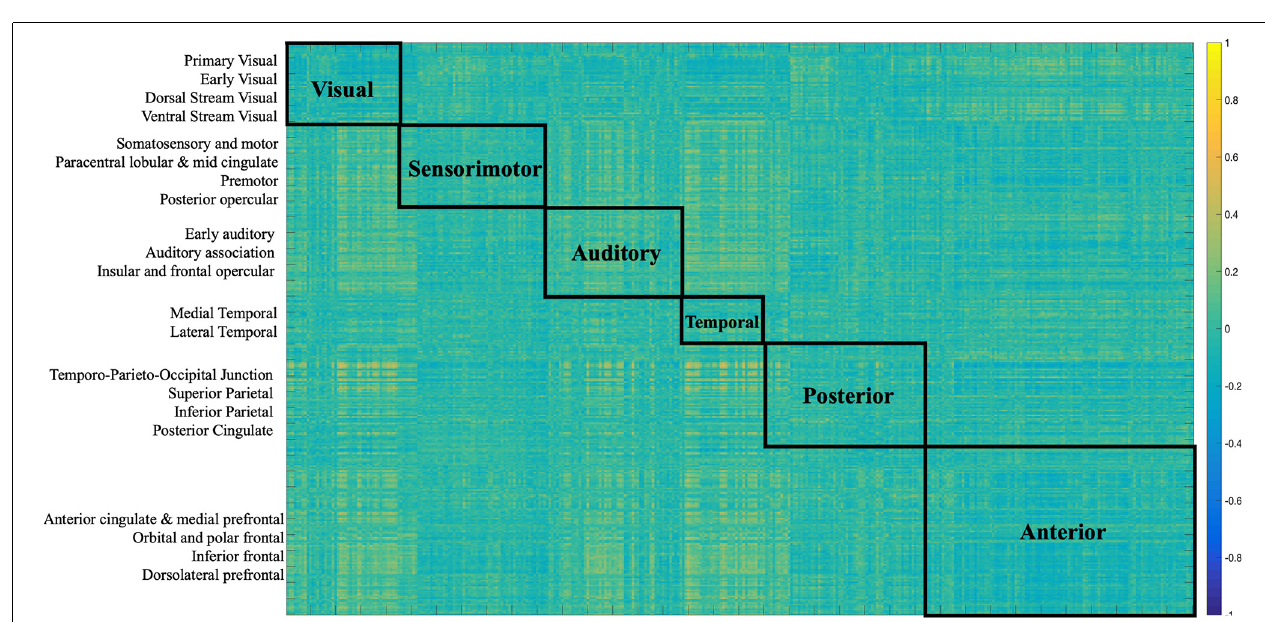
FIGURE 1 | Pearson’s Correlation among the cognitive measures. The color bar indicates the strength of the correlation (r). Abbreviations: MH MR1, Mill Hill Vocabulary Test; SRT MRI1M, mean performance of Simple Reaction Time; MDA MRI1, Matrices Task with position recall; MAT MRI1, Matrices Task with word position recall; CL6 MRI1, mean performance on Letters Comparison Task with six letters; CL9 MRI1, mean performance on Letters Comparison task with nine letters; RAVEN MRI1, Raven Progressive Matrices 38; CL6 MRICV, Coefficient of variation of Letters Comparison task with six letters; CL9_MRI1CV, Coefficient of variation of letters comparison task with nine letters; Stroop MRI1, Color Stroop Task. *Indicates significance at p < 0.00001.